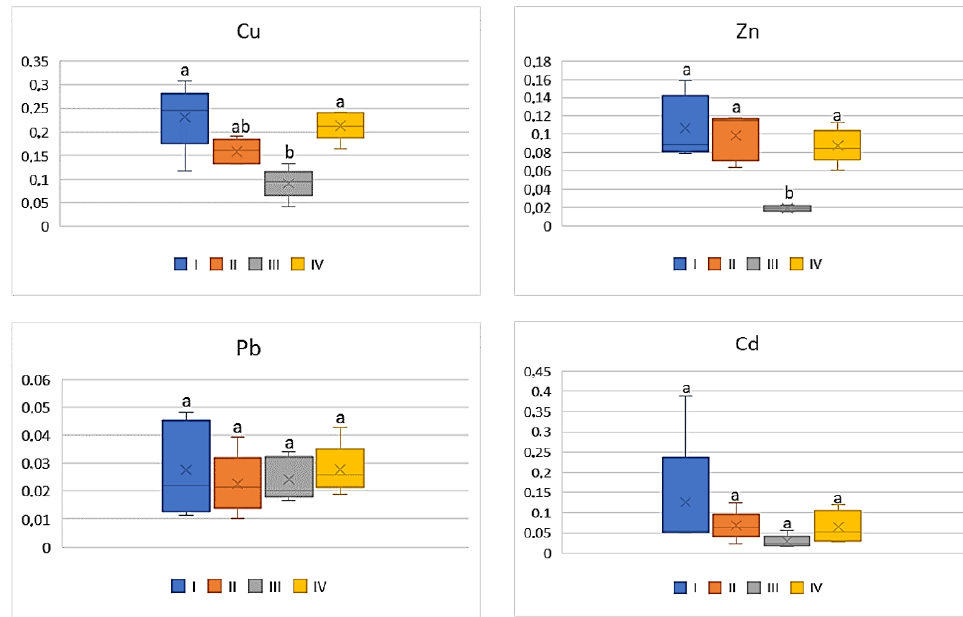
Figure 5. BCF values for beetroot depending on the metal and study zones. The same letters mean no significant differences between the values.